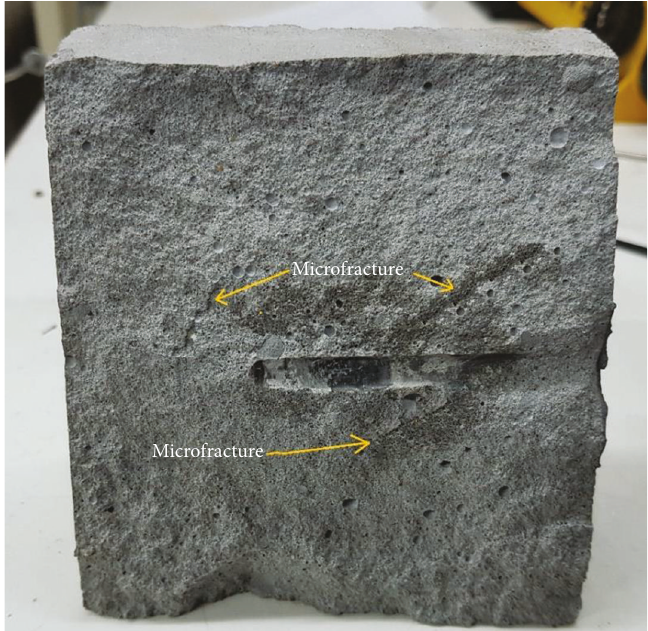
Figure 14: A split view of 1/4-inch hole diameter cement block after thermochemical fracturing showing the presence of microfractures around the region of simulated